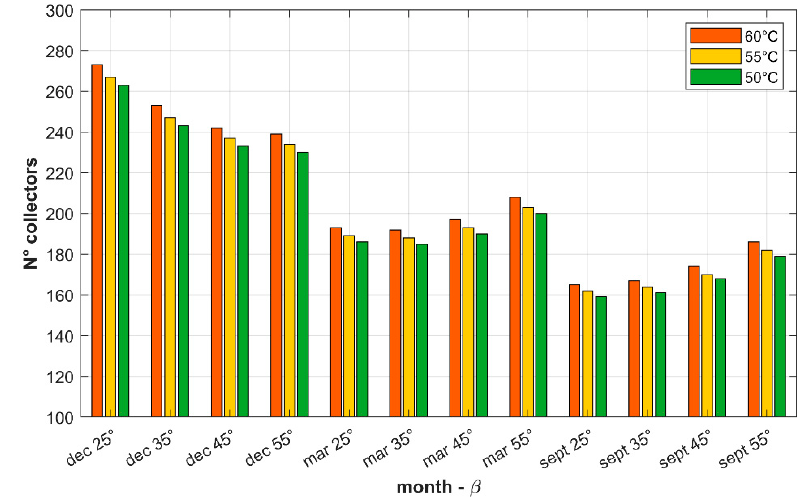
Figure 2. Number of collectors of the solar field.